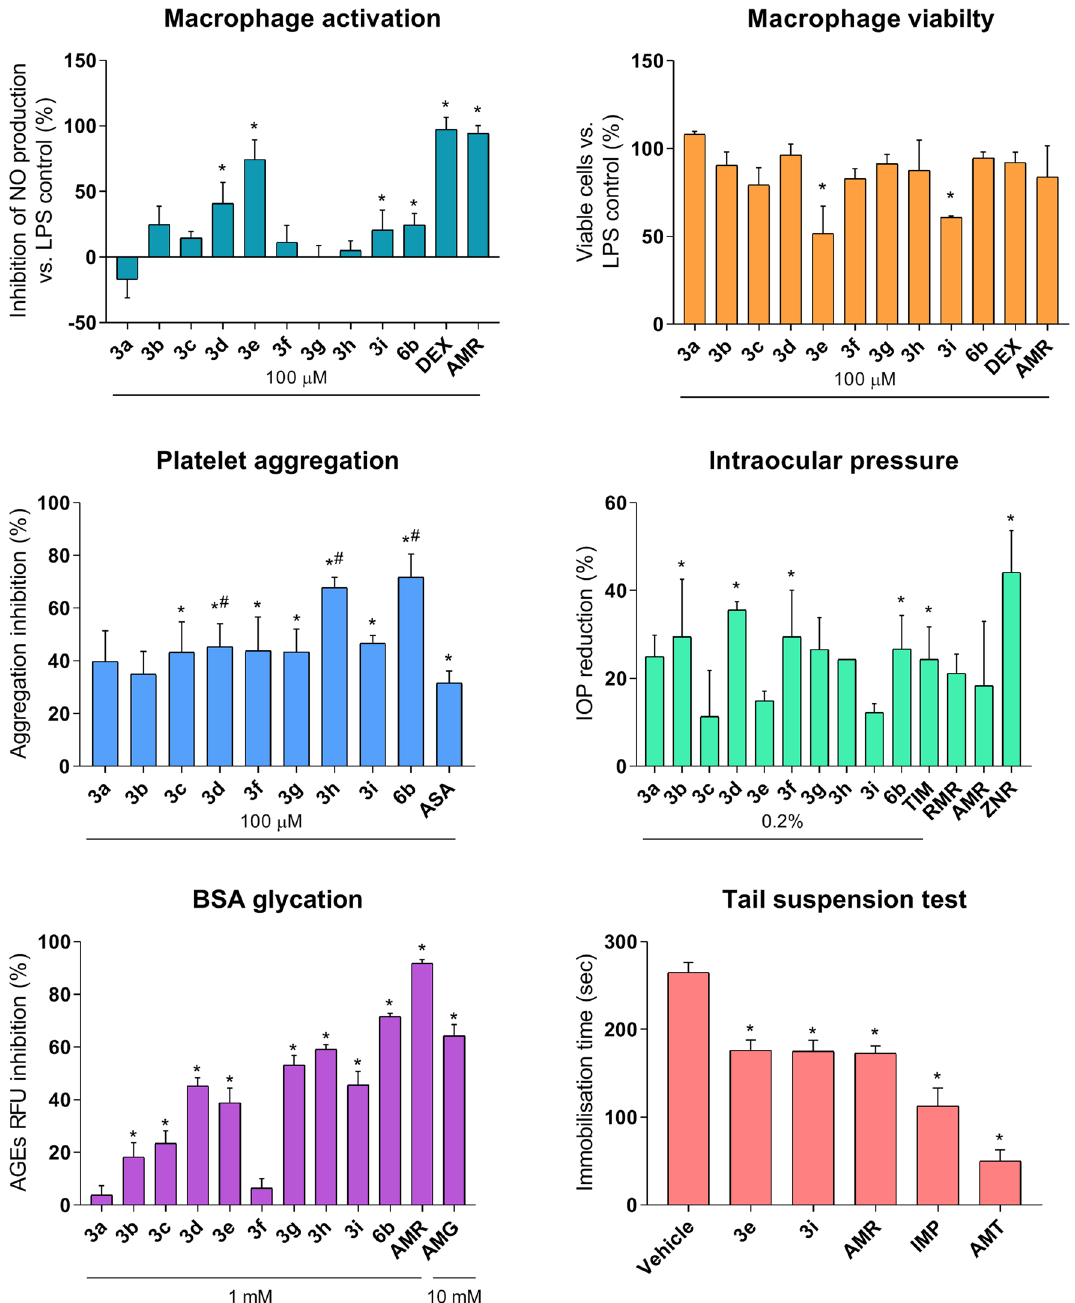
Figure 4. Pharmacological evaluation of the target compounds. Data are shown as mean ± SD. Statistical significance: * p < 0,05 vs. negative control; # p < 0,05 vs. ASA (1-way ANOVA). AMR amiloride, RMR